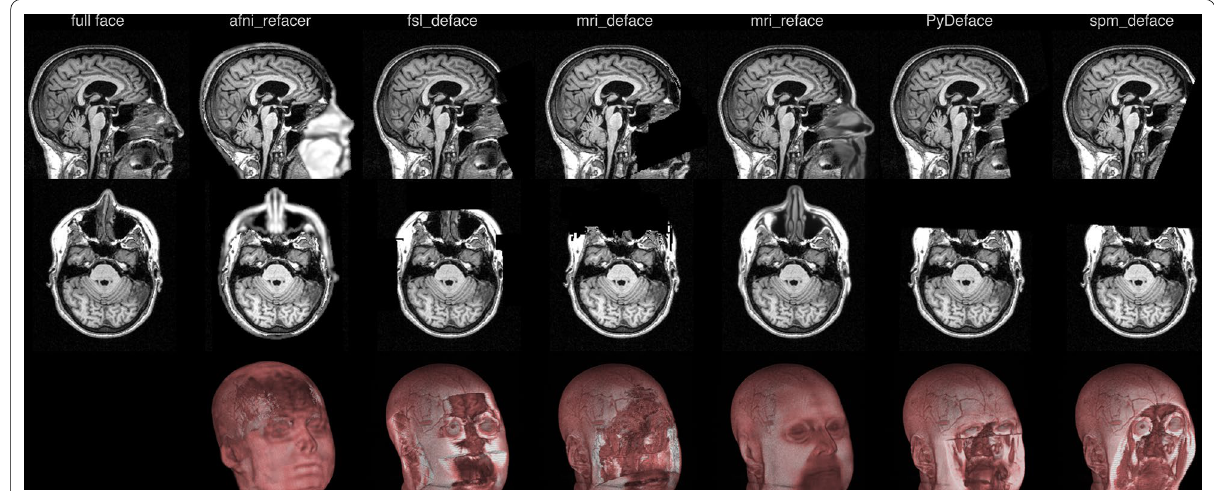
Fig. 1 Example of successful defacing approaches on an Alzheimer’s disease patient (female, 69 years of age). Top row shows the sagittal reformations of the defaced image volume, second row shows the axial reformations and the bottom row shows volume renderings. The volume rendering of the full face image (lower left) has been omitted for privacy